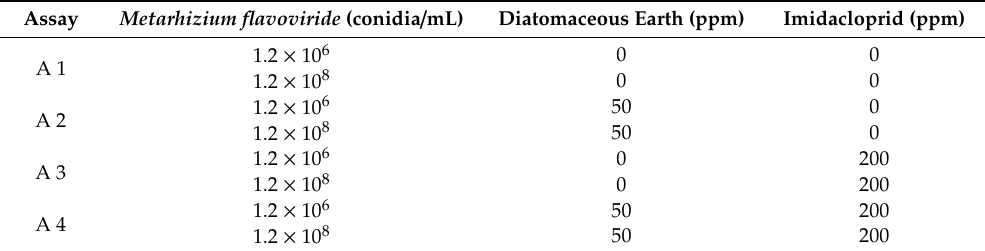
Table 1. Combinations of Metarhizium flavoviride , diatomaceous earth, and imidacloprid against the adults and second instar larvae of WFT ( F. occidentalis ) in e ffi cacy studies. Assay Metarhizium flavoviride (conidia / mL) Diatomaceous Earth (ppm) Imidacloprid (ppm) 1.2 × 10 6 A 1